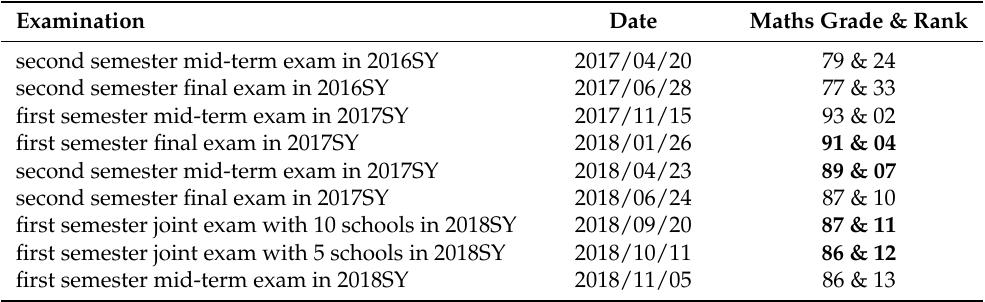
Table 3. Examination Data of Student 14295 Complemented by Linear Interpolation